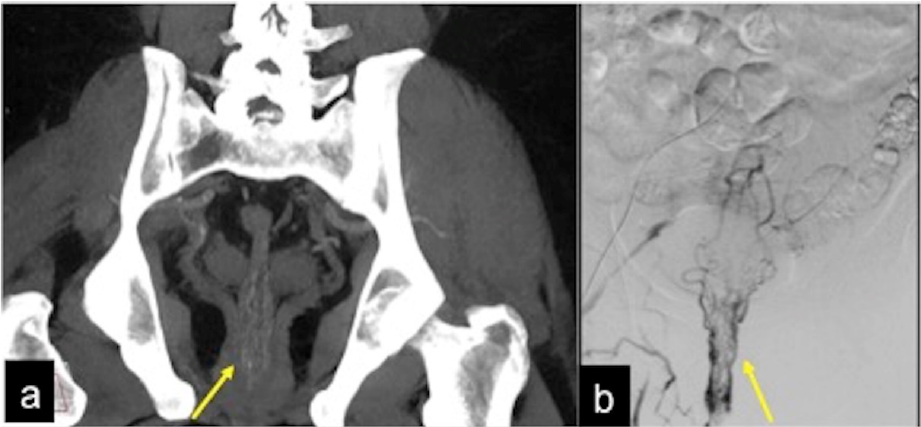
Figure 16. CTA multiphasic study of caecum sentinel clot in a patient with hematochezia. A small amount of spontaneous hyperdensity is collected at caecal fondus, resulting visible in the pre-contrast ( a ), arterial ( b ) and venous ( c ) phases with analogous morphologic and densitometric characteristics (arrow). This finding is suggestive of a sentinel clot and presumable recent bleeding.